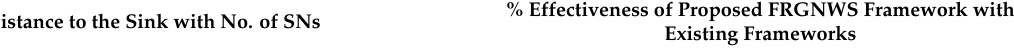
Table 5. The average % effectiveness of the proposed novel framework for the average hop distance to the sink metric with variations in the number of SNs.